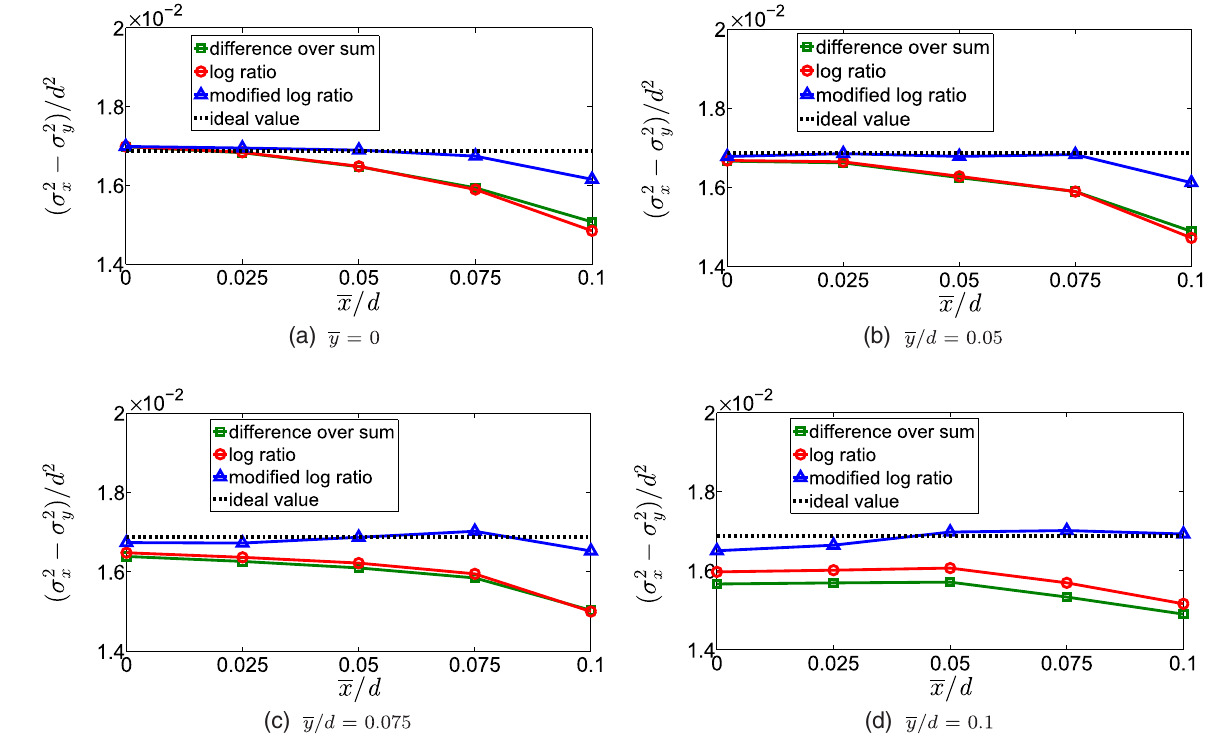
FIG. 15. ð σ 2 x − σ 2 y Þ =d 2 as a function of the beam position; c x ¼ 4719 , c y ¼ 0 . 1177 .